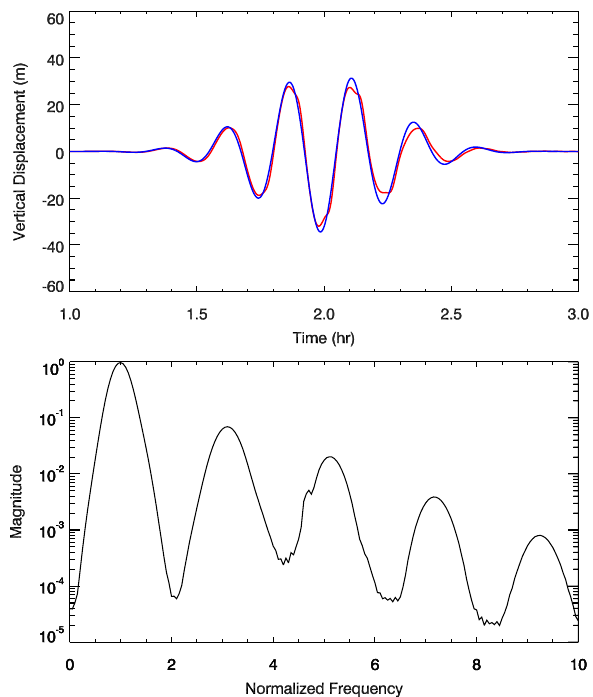
Fig. 4. As in Fig. 1, but for the SPB response to a gravity wave packet defined by Eq.